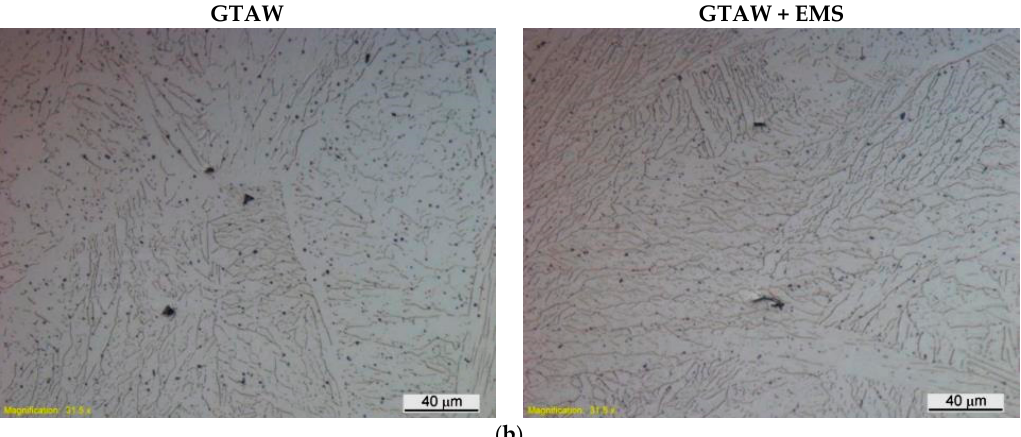
Figure 13. The optical microscope micrographs of the CF-8A butt-welds: ( a ) HAZ and ( b ) fusion zone [8].